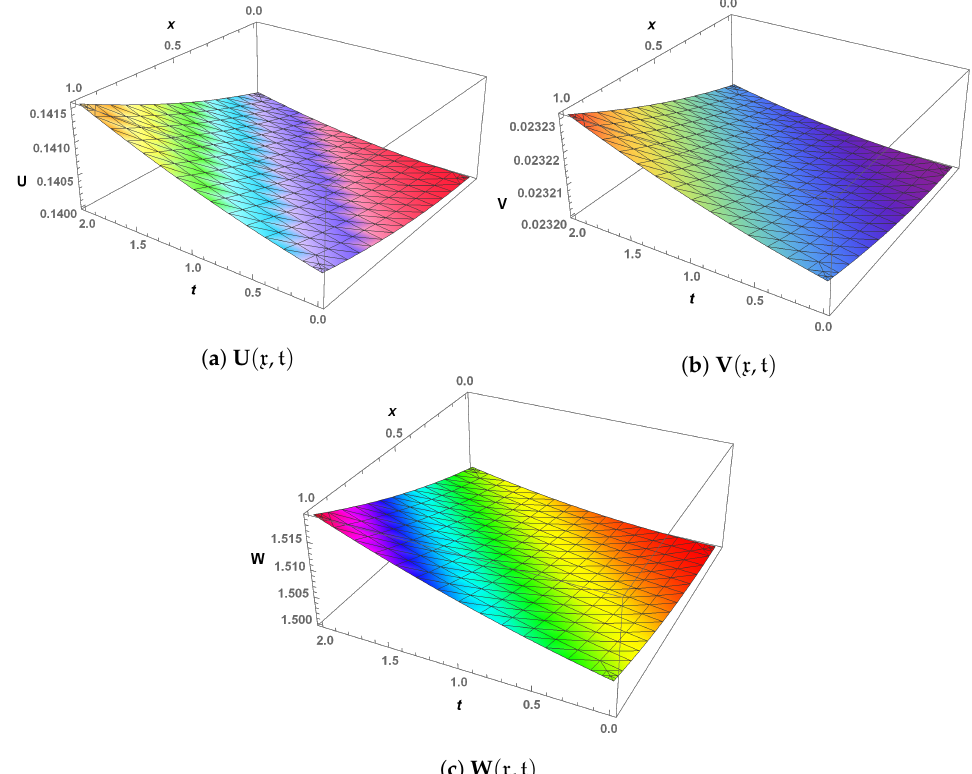
Figure 7. Three-dimensional (3D) plot of LHPM solution in Example 3 when β = 1, α = 0.1, c 0 = 1.5 and c 2 = p =